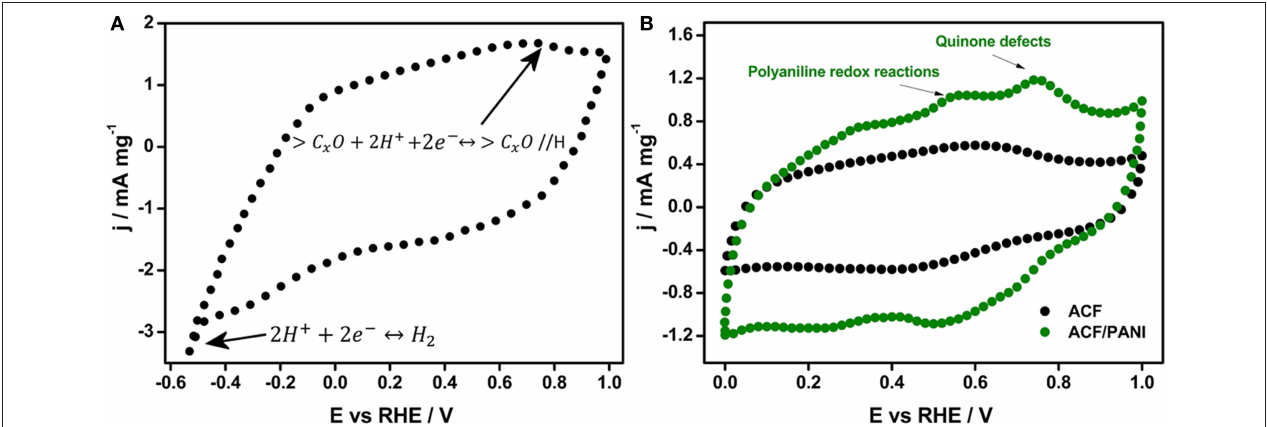
FIGURE 5 | Steady state cyclic voltammograms of: (A) AC (negative electrode) and (B) ACF/PANI (positive electrode) and pristine ACF in 0.5M H 2 SO 4 . Scan rate: 5mV s − 1 . Three-electrode cell.